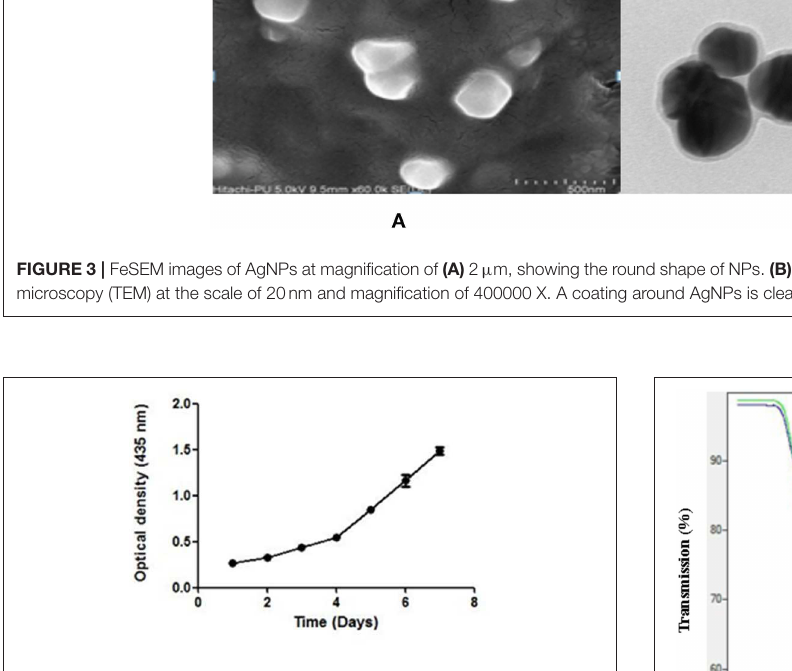
FIGURE 4 | The UV absorbance of AgNPs at 435nm after an interval of 24h for 7 days. A continuous increase in the absorbance of nano-particles indicate toward its stability.